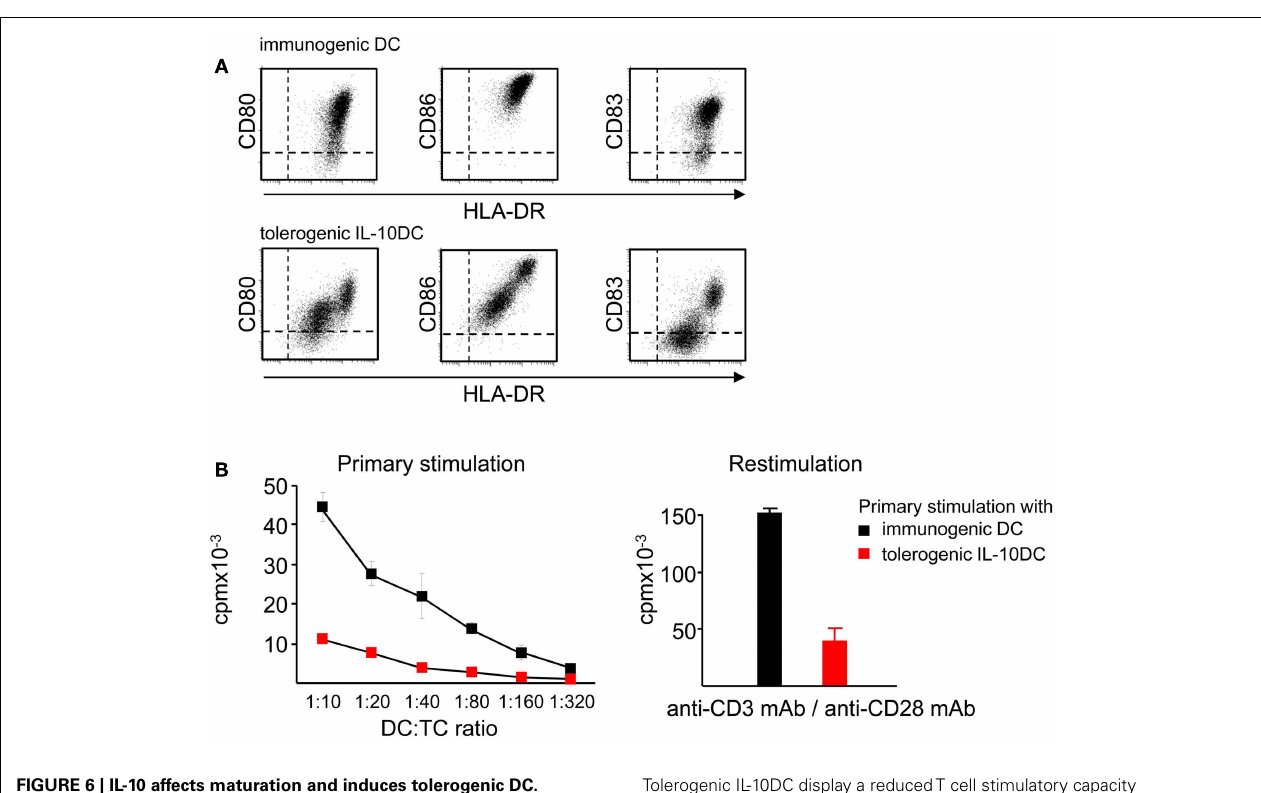
FIGURE 6 | IL-10 affects maturation and induces tolerogenic DC. (A) Presence of IL-10 during the maturation process of immature DC impairs the upregulation of costimulatory molecules like CD80 and CD86 resulting in the tolerogenic phenotype of IL-10DC. (B)